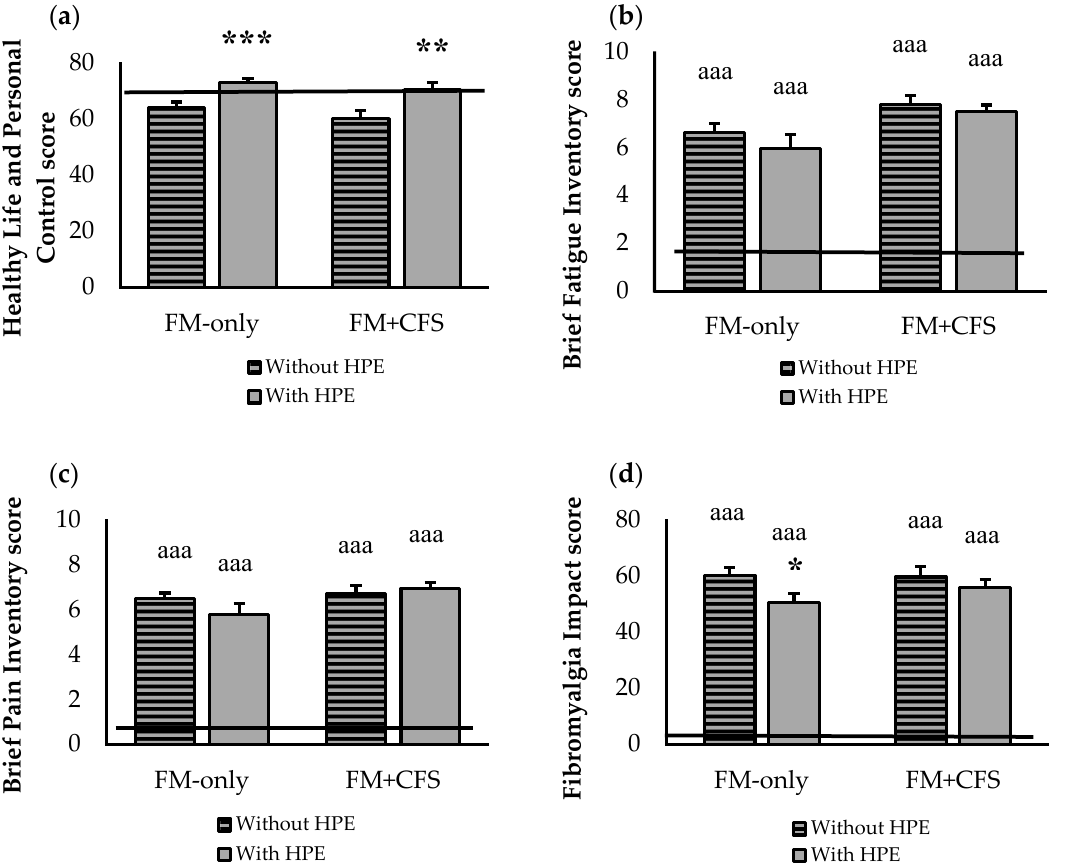
Figure 4. Effect of Habitual Physical Exercise (HPE) in patients diagnosed only FM (FM-only, n = 38: 27 without HPE and 11 with HPE) and codiagnosed with CFS (FM + CFS, n = 32: 15 without HPE and 17 with HPE), on quality of life: perceived levels of ( a ) healthy life and personal control ( b ) fatigue; ( c ) pain and ( d ) fibromyalgia impact. Horizontal line represents values obtained in the age-matched reference group of “healthy” women without FM. Columns represent the mean ± SEM of each experimental group with or without reported HPE. FM: Fibromyalgia, CFS: Chronic Fatigue Syndrome. * p < 0.05, ** p < 0.01, *** p < 0.001 with respect to the corresponding group without HPE. aaa p < 0.001 with respect to reference group. “Without HPE”: participants non reporting HPE; “With HPE”: participants reporting